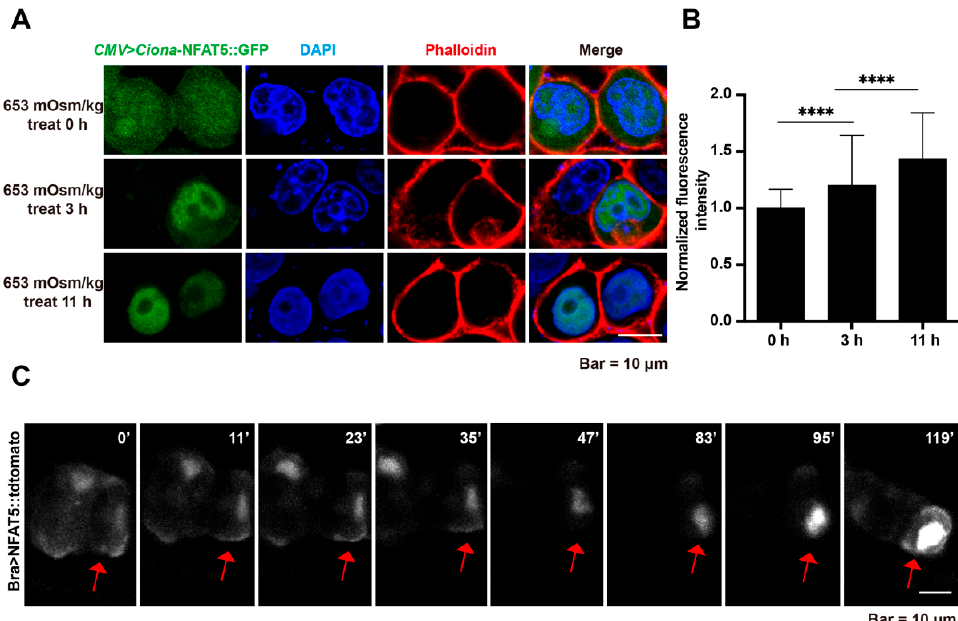
Figure 3. Ciona -NFAT5 responds to hypertonicity. ( A ) HeLa cells were transfected with Ciona - NFAT5. Representative cell images at 0, 3, and 11 h after hypertonic treatment (653 mOsm/kg). ( B ) Quantification of Ciona -NFAT5 translocation from the cytoplasm to the nucleus upon hypertonic treatment. The fluorescence intensity of the nucleus/cytoplasm was measured by image J. Asterisks (****) represented statistical significance ( p < 0.0001). ( C ) Subcellular dynamics of Ciona -NFAT5 in Ciona notochord cells. The scale bar represents 10 μ m.